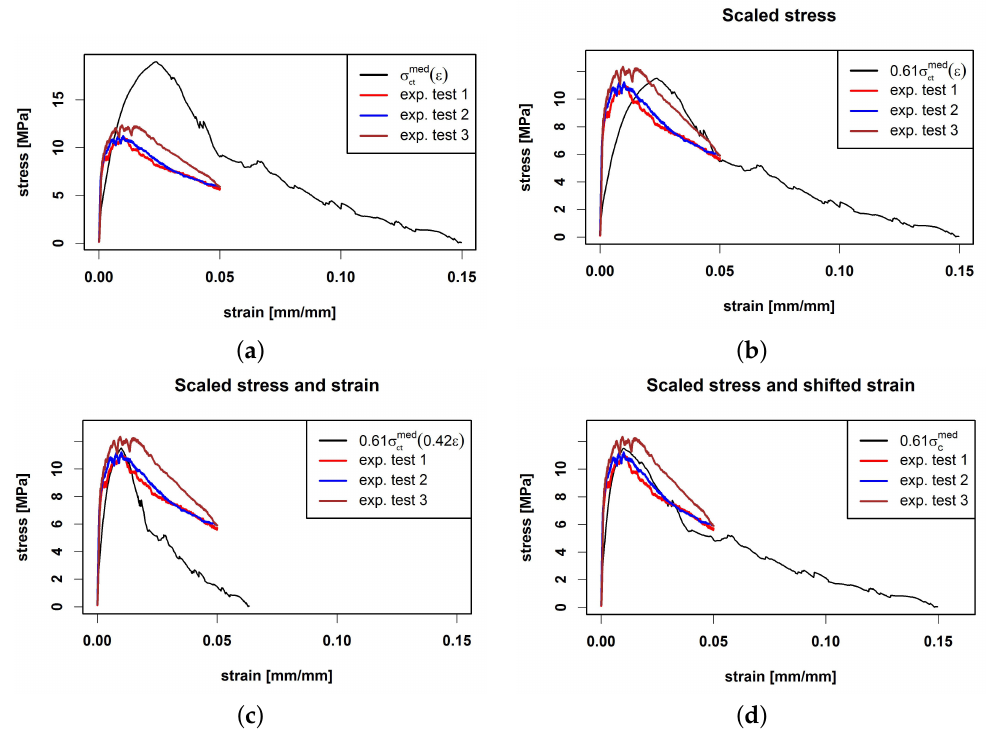
( ε ) ( a ) compared with three experimental ct = 0.61 ( b ) and additionally scaled strain by ult